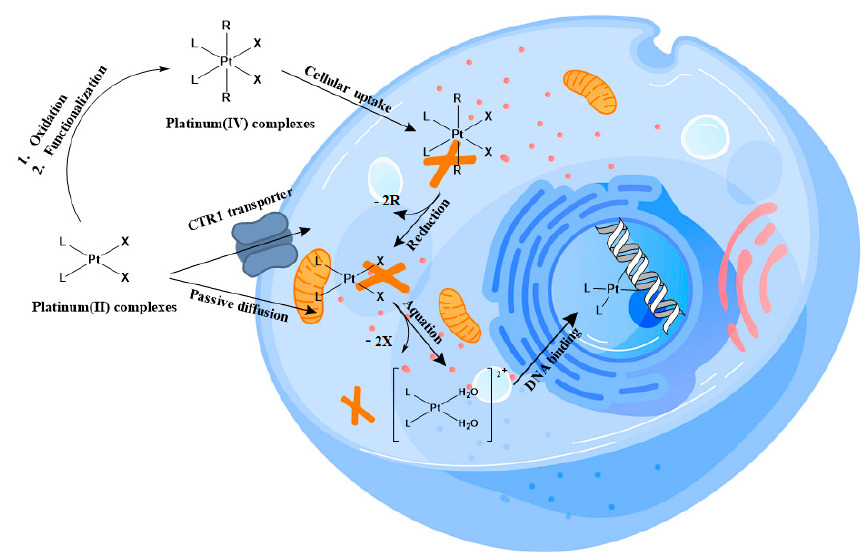
Figure 1. Pt(II) and Pt(IV) trafficking within cells.